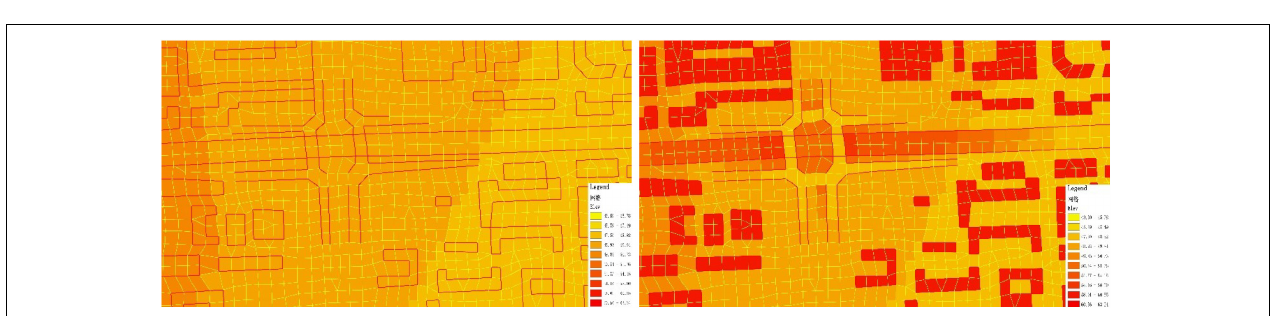
FIGURE 2 | Control line for mesh generation (the red line).